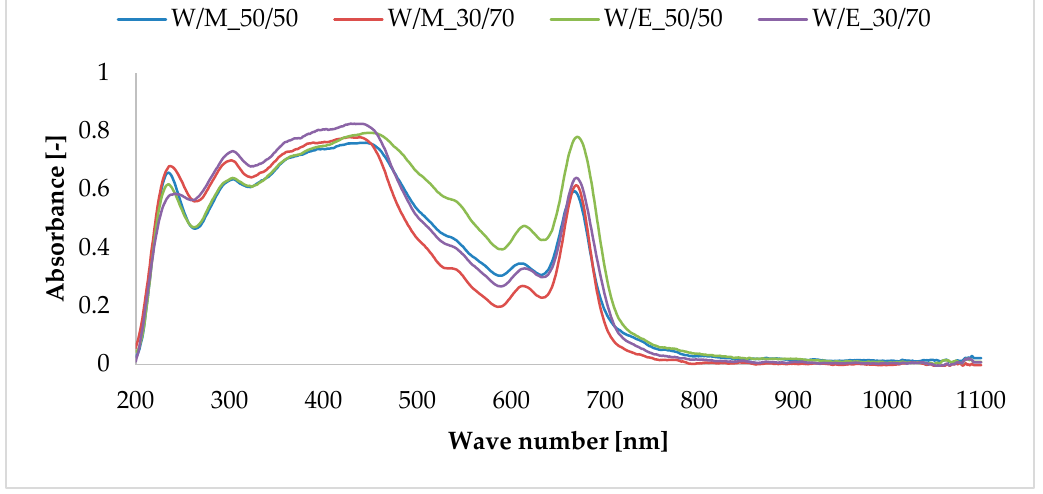
Figure 2. The UV–Vis spectrum of horsetail extracts.